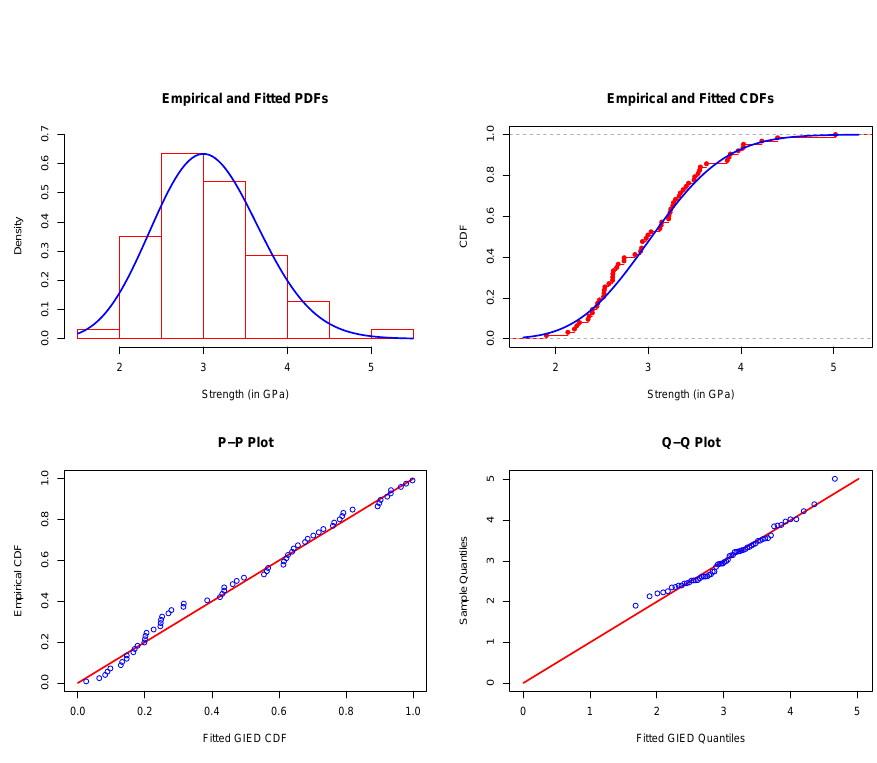
Figure 1 – Diagnostic plots for the fitted GIED for data set 1 ( X : gauge length 10 mm).